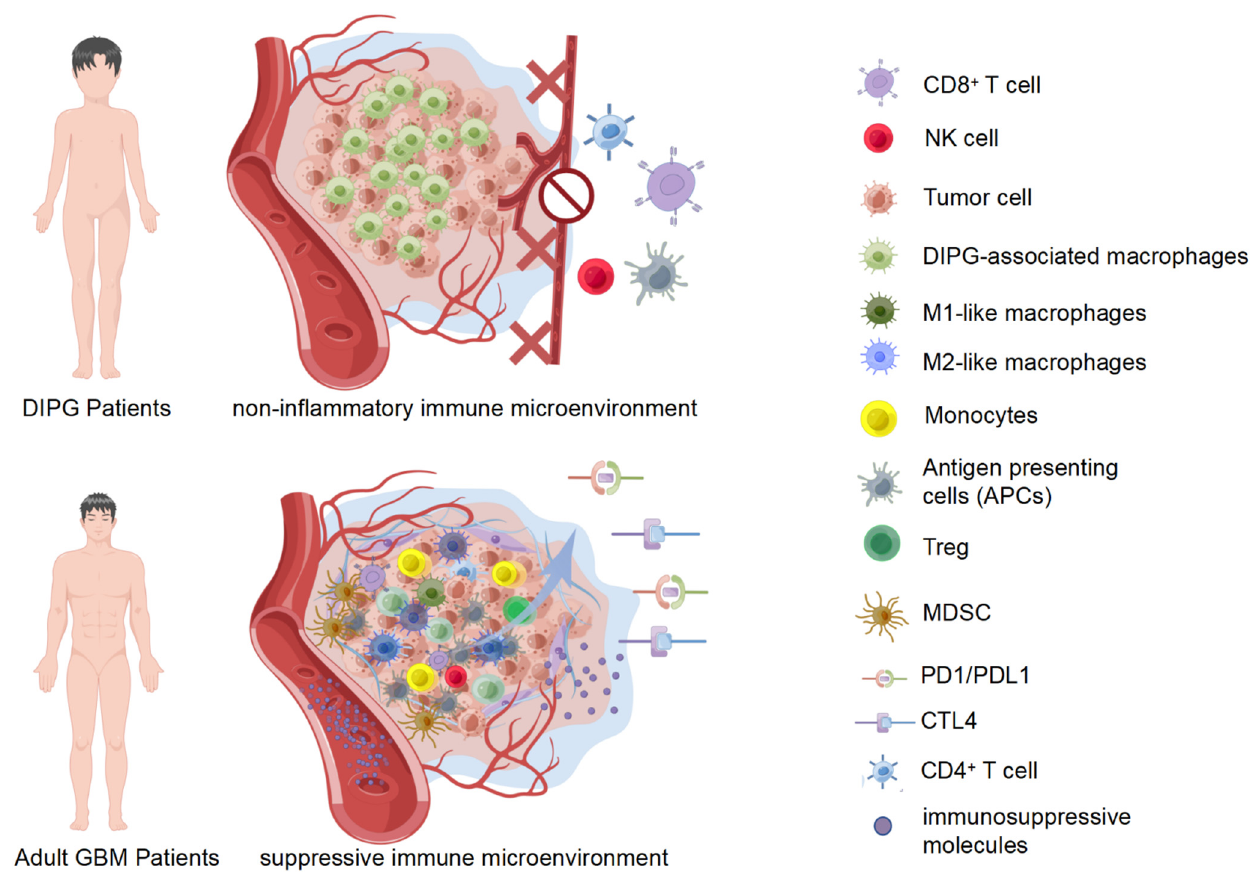
Figure 2. Characterization of the DIPG-associated immune microenvironment. DIPG is a “cold tumor”, indicating reduced immune cells infiltration, lower secretion of inflammatory factors, rare antigen-presenting cells, isolated and defective immune death mechanisms, and a nearly deserted immune microenvironment. Besides, DIPG-associated macrophages do not fully fit the M1 or M2 classification. In general, immunosuppression is not a major feature of the DIPG microenvironment, compared with adult GBM.